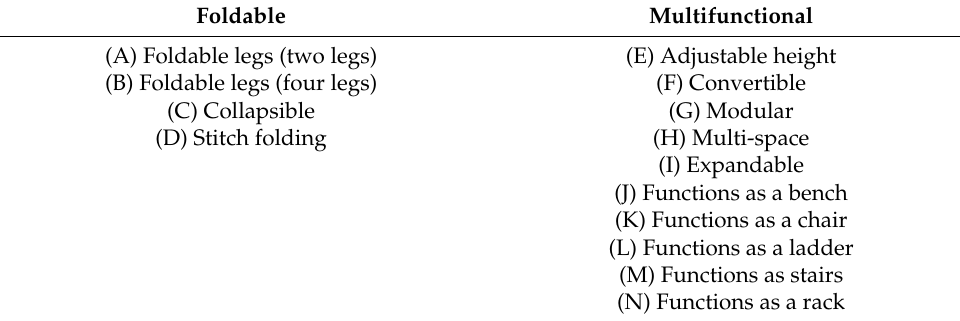
Table 3. Key features and functions by